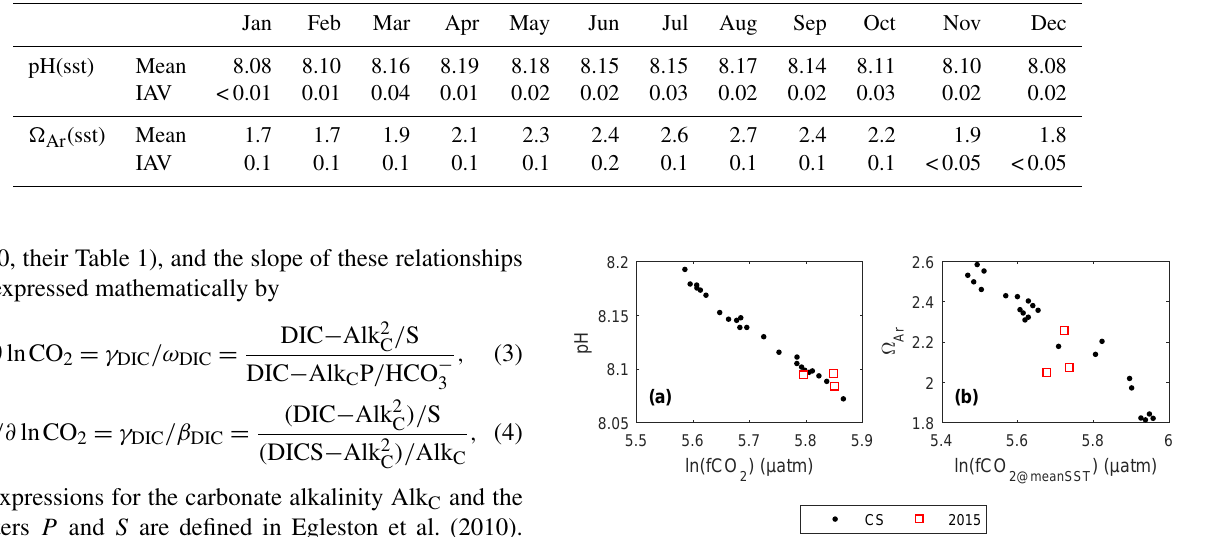
Table 4. Monthly mean values for pH(sst) and (cid:127) Ar (sst) and associated interannual variability (IAV), computed as standard deviations, in the study area for the period 2005–2009.